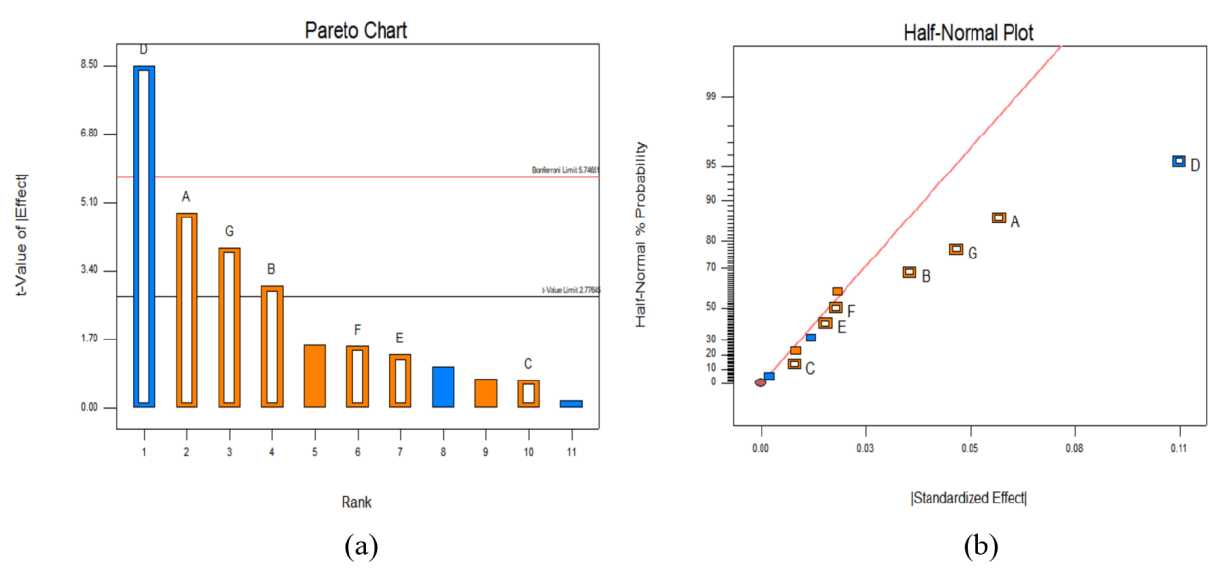
Figure 4. ( a ) Pareto chart of the Plackett-Burman experiment; ( b ) distribution chart of the Plackett- Burman experiment results. (A: Content of sucrose; B: Content of NH 4 H 2 PO 4 ; C: Content of MgSO 4 ; D: Content of Tween-80; E: Content of rice husk; F: Content of KH 2 PO 4 ; G: Content of wheat bran; R1: Extraction rate of diosgenin).